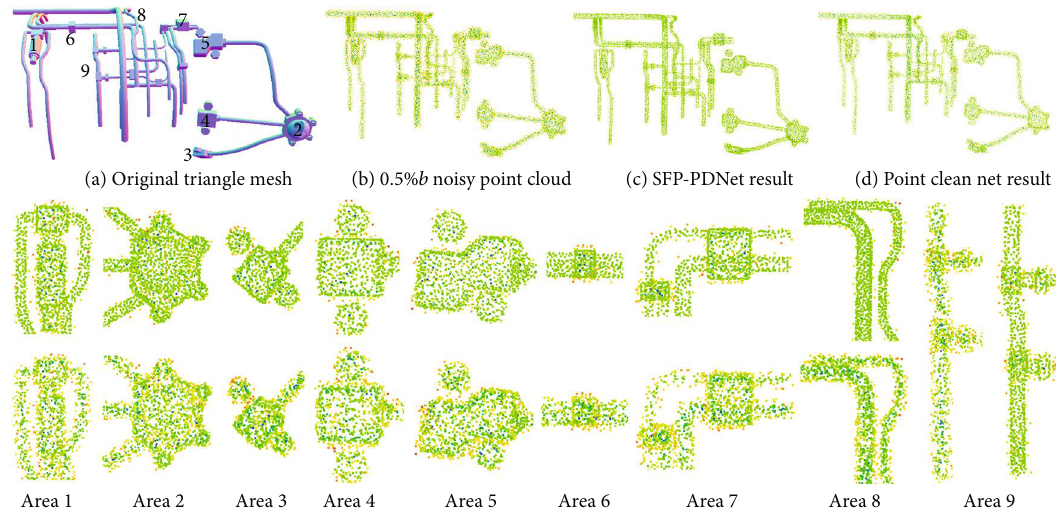
Figure 26: Qualitative comparison between SFP-PDNet and PointCleanNet on aero-engine accessory system. The larger versions correspond to these areas indicated by numbers in Figure (a). SFP-PDNet (the second row) PointCleanNet (the third row). For area 9, PointCleanNet (left) SFP-PDNet